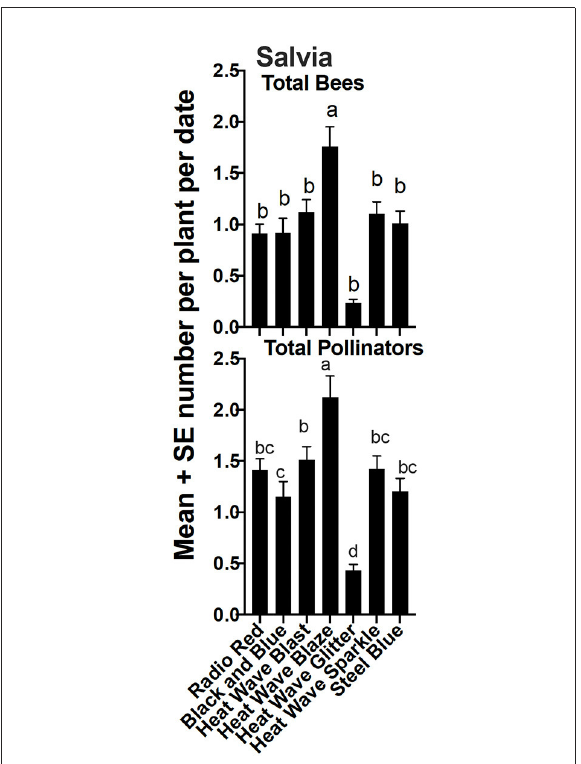
FIGURE7 Mean ± se total bees and total flower visitors (pollinators) comparison among salvia cultivars in a 2-year study in central Georgia, USA. The superscript alphabets means with the same letters are not significantly different, p >